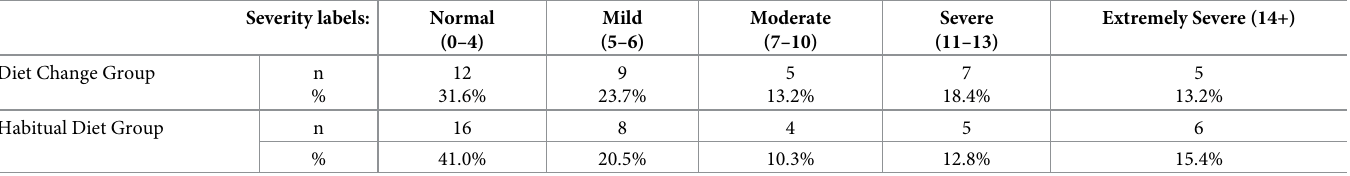
Table 2. Level of severity on the DASS-21 depression subscale at baseline for those in the diet change and habitual diet groups. Severity labels: